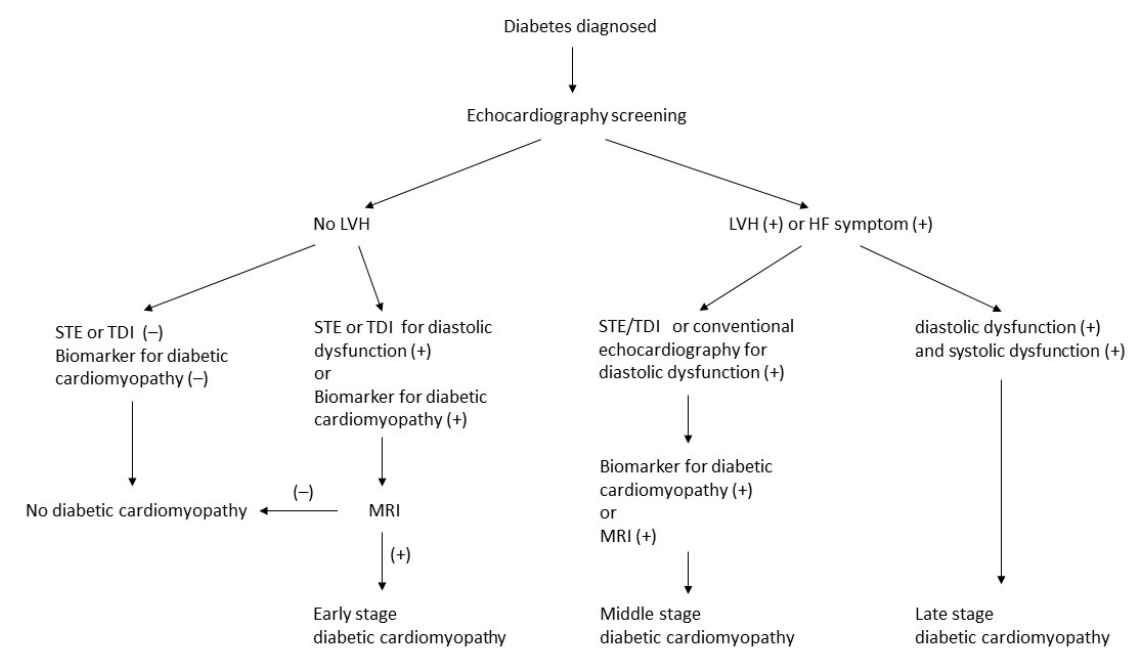
Figure 4. Proposed algorithm for diagnosis of diabetic cardiomyopathy. LVH: left ventricular hypertrophy; MRI: magnetic resonance imaging; STE: speckle-tracking echocardiography; TDI; tissue Doppler imaging.